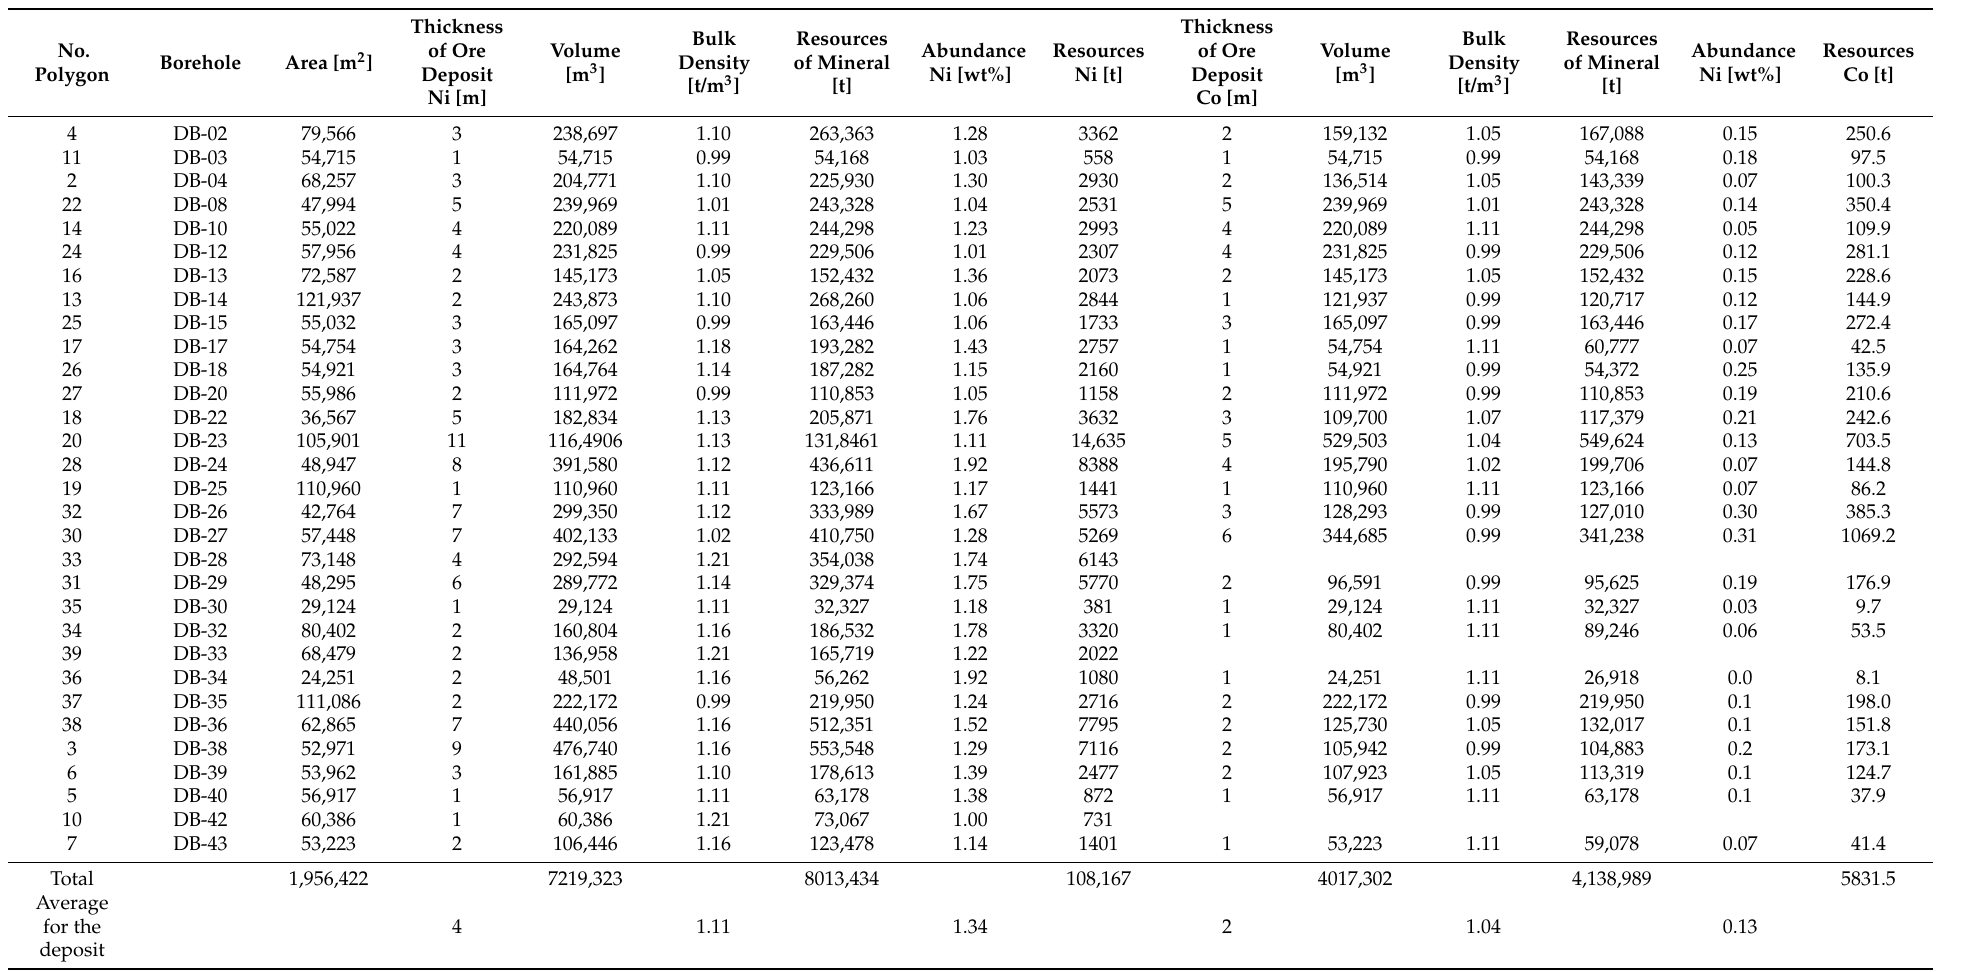
Table A2. Parameters of individual polygons used for resource estimation using the polygon method and results of calculations. Cut-off Ni ≥ 1.0 wt%. Calculations for the whole studied area (also outside the IUP concession